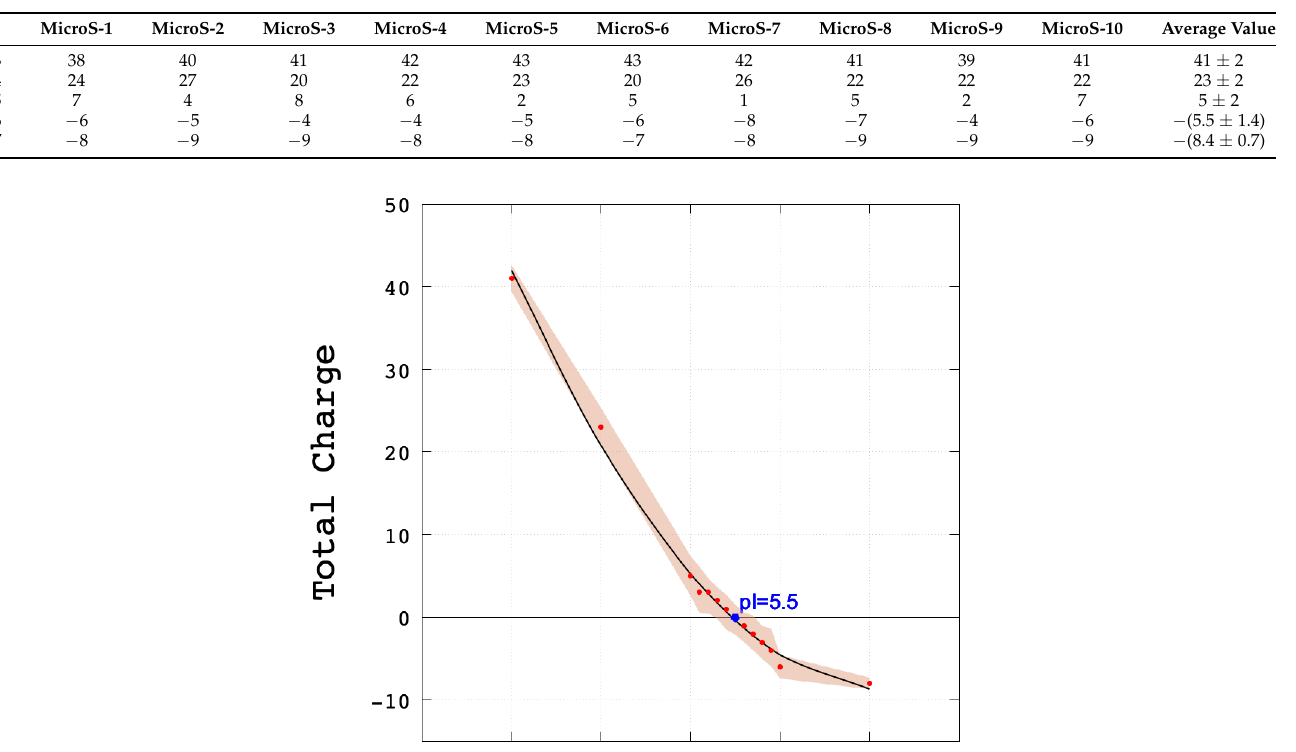
Table 1. Total charge of Mpro as a function of pH for the different microstates (MicroS).